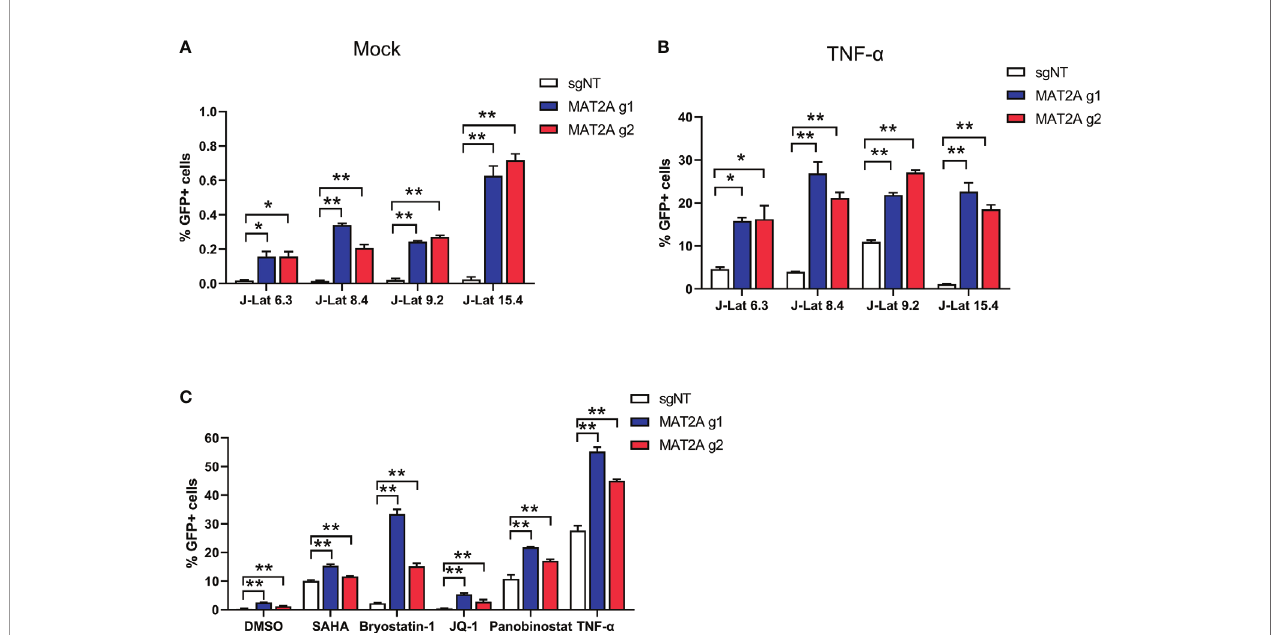
FIGURE 3 | MAT2A deletion promoted latent HIV-1 reactivation. (A, B) The effect of MAT2A on HIV-1 latency reactivation is independent of the proviral integration site. Flow cytometry analysis of GFP positive cells in MAT2A knockout J-Lat cell lines with or without TNF- a stimulation. sgNT knockout cells served as control. (C) MAT2A knockout signi fi cantly facilitated LRA-mediated latent HIV-1 reactivation in J-Lat 9.2 cells. MAT2A knockout J-Lat 9.2 cells were treated with DMSO, SAHA, Bryostatin-1, JQ1, Panobinostat and TNF- a for 24 h GFP-positive cells were measured by fl ow cytometry. Data were presented as mean ± SD from three independent experiments (Student ’ s t-test, *p < 0.05, **p <